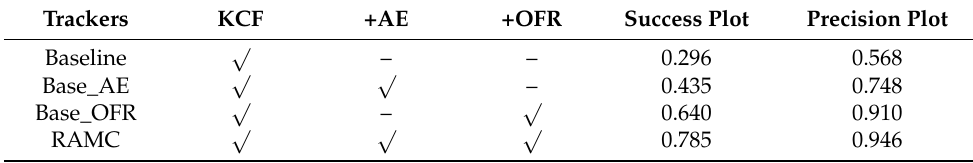
optimal performance. Table 3. Components and results of ablation experiments. Trackers